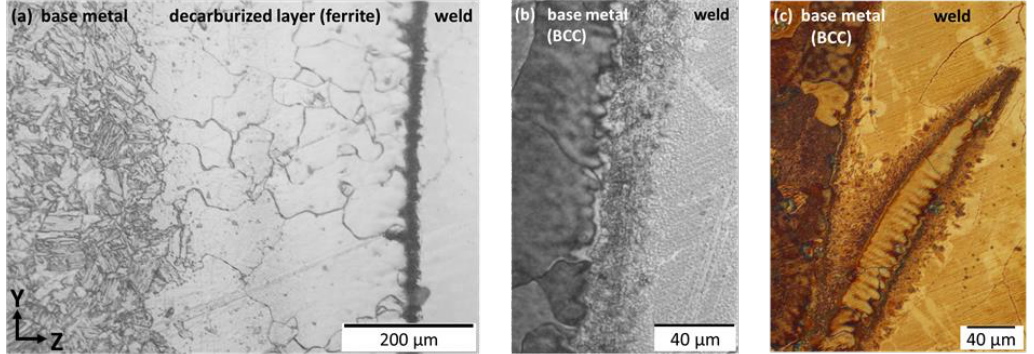
Figure 10. Optical micrographs of the near interface region after welding followed by PWHT heat treatment during 16 h at 610 °C. ( a ) Decarburized layer in the 18MND5 base metal and carburized layer (in dark) on the weld side. Magnifications around the fusion line showing the phantoms of the dendritic network in the ferrite grains of the locally decarburized 18MND5: ( b ) on the base metal side; ( c ) in an unmelted steel part.